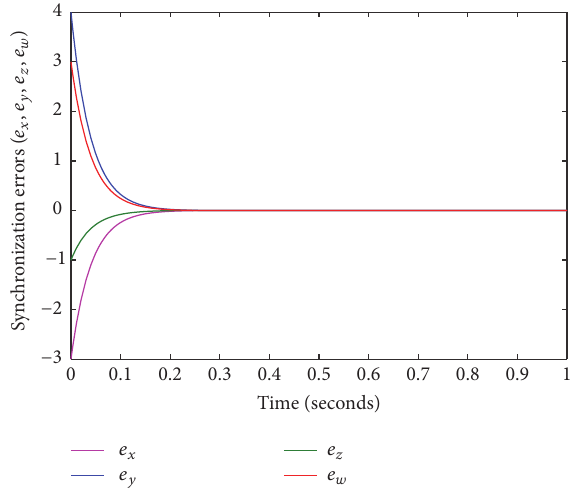
Figure 8: Time history of synchronization errors ( 𝑒 𝑥 ,𝑒 𝑦 , 𝑒 𝑧 ,𝑒 𝑤 ).